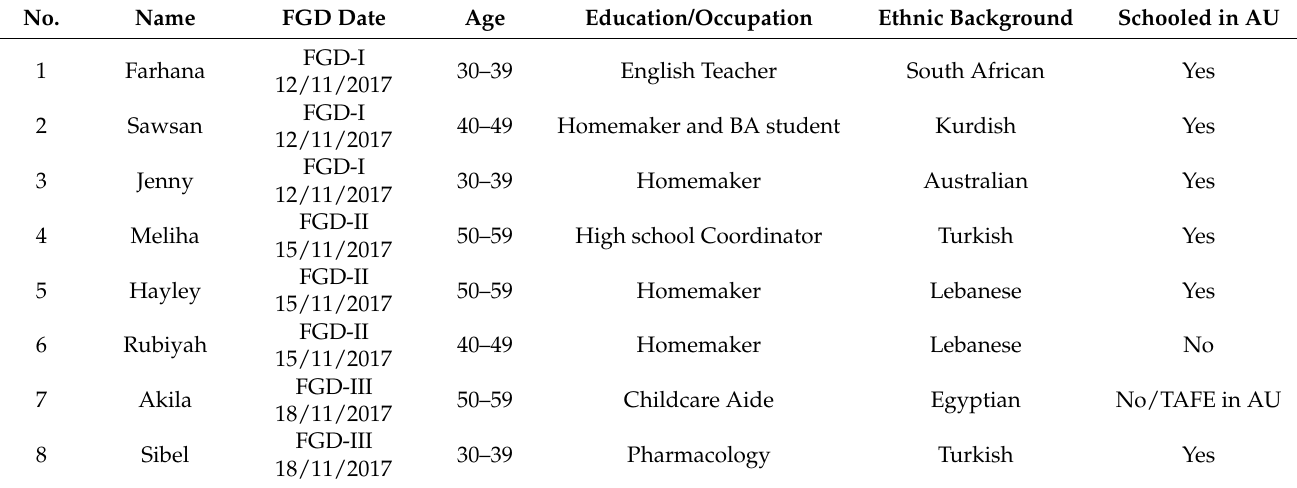
Table 3. Demographics of Focus Group Discussion